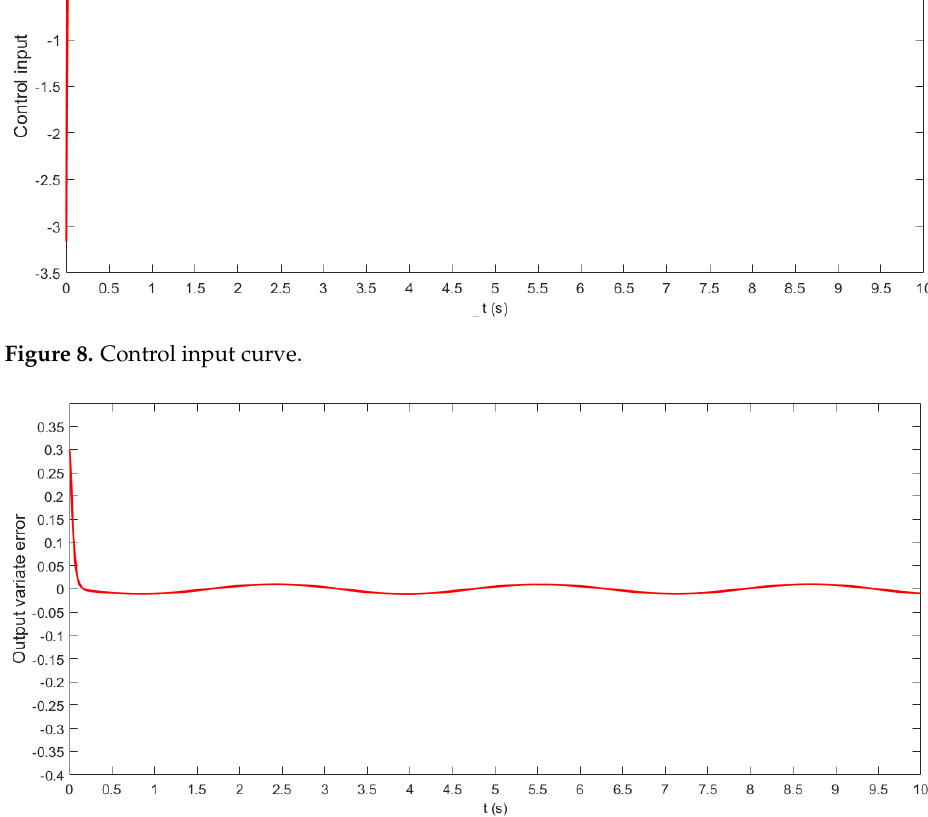
Figure 9. Output error curve.